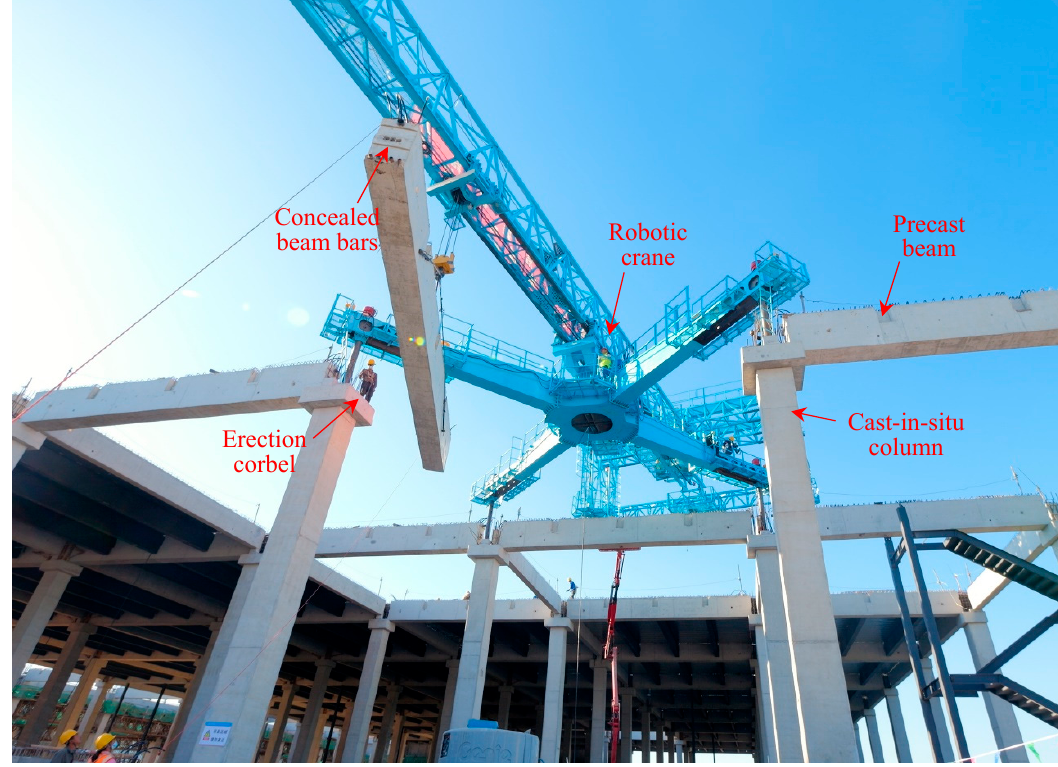
Figure 1. An example project using a four-leged robotic crane. After the crane has walked away, headed reinforcement is used within the joint core to anchor the bottom rebars of the precast beams as well as their top rebars in place, as illustrated in Figure 2a. Then the joint, the upper column, and the remaining part of the beams are cast at the job site, as shown in Figure 2b.